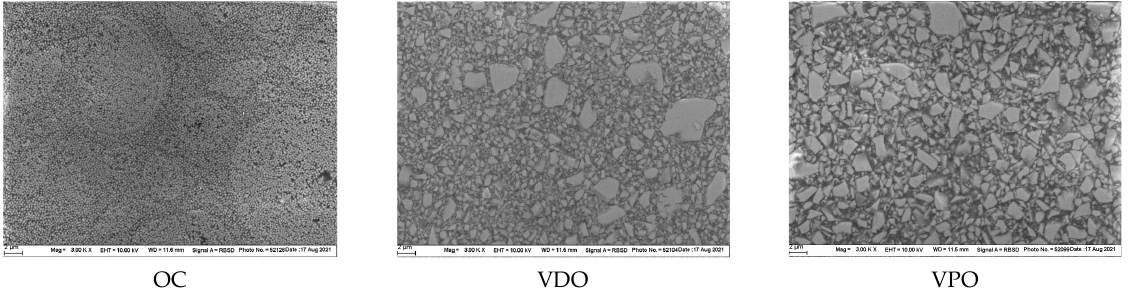
Figure 12. SEM images, electron backscatter diffraction mode. Structural appearance of the filler system in OC = Omnichroma; VDO = Venus Diamond One, and VPO = Venus Pearl One in 3000× magnifications (scale = 2 μm). 4. Discussion Dental restorative materials are exposed to a challenging environment in the oral cavity over a long period of time, which can alter their initial, targeted, properties. Since the materials studied are polymer-based composites that function below their glass tran- sition temperature, the polymer part of the material is subject to physical aging, also de- fined as structural recovery [22]. Due to the rapid light-curing process, the polymer is normally in a non-equilibrium thermodynamic state while the polymer chains undergo